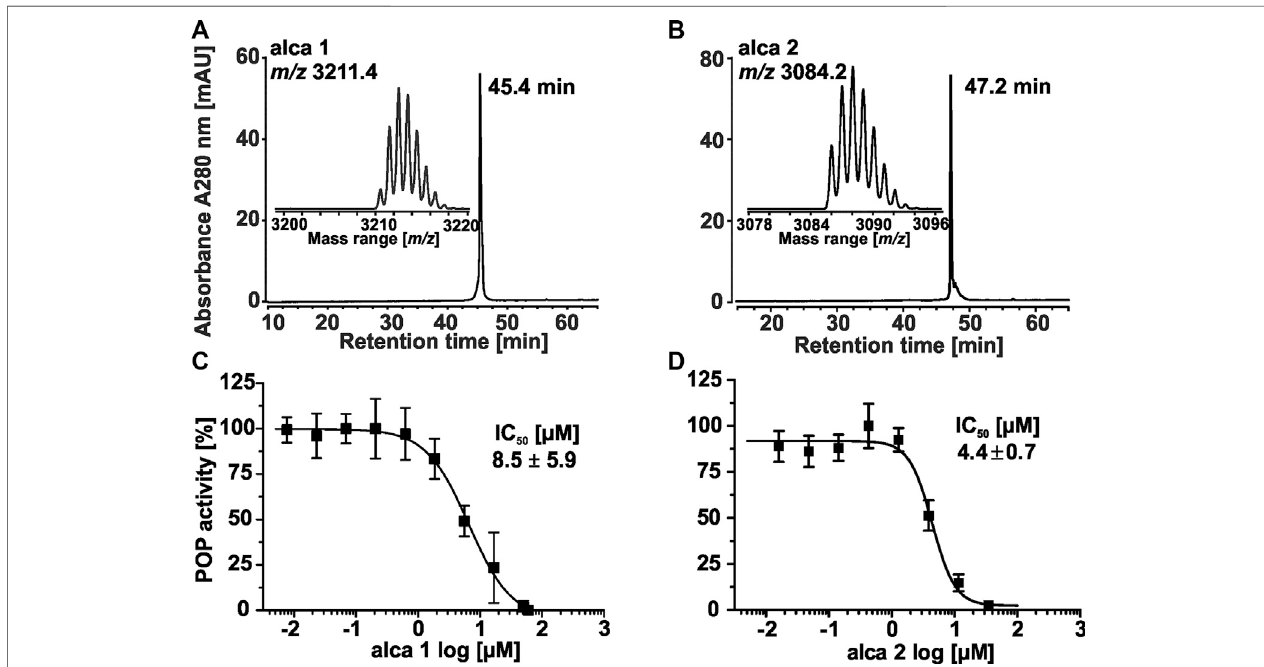
FIGURE 4 | Isolation of representative alca peptides for concentration dependent inhibition of POP activity. Two peptides (denoted as alca) were obtained in the milligram scale by repeated preparative and semipreparative HPLC fractionation. The major peptides in bioactive fraction 6 (alca 1) and in − 7 (alca 2) were puri fi ed with RP-HPLC.TheA 280 trace ofachromatogramallowed puritydetermination foralca1with ≥ 99%.Themasstraceoftheisolatedmaterialisshown intheinsert.Thenative monoisotopic detected mass is m/z 3,211.4 (A) . The corresponding A 280 trace for alca 2 obtained a purity of ≥ 82%, which was considered for calculation of peptide concentration (B) . A dose response study was conducted to evaluate the inhibition activity (IC 50 ) of isolated peptides. POP proteolytic activity inhibition assays